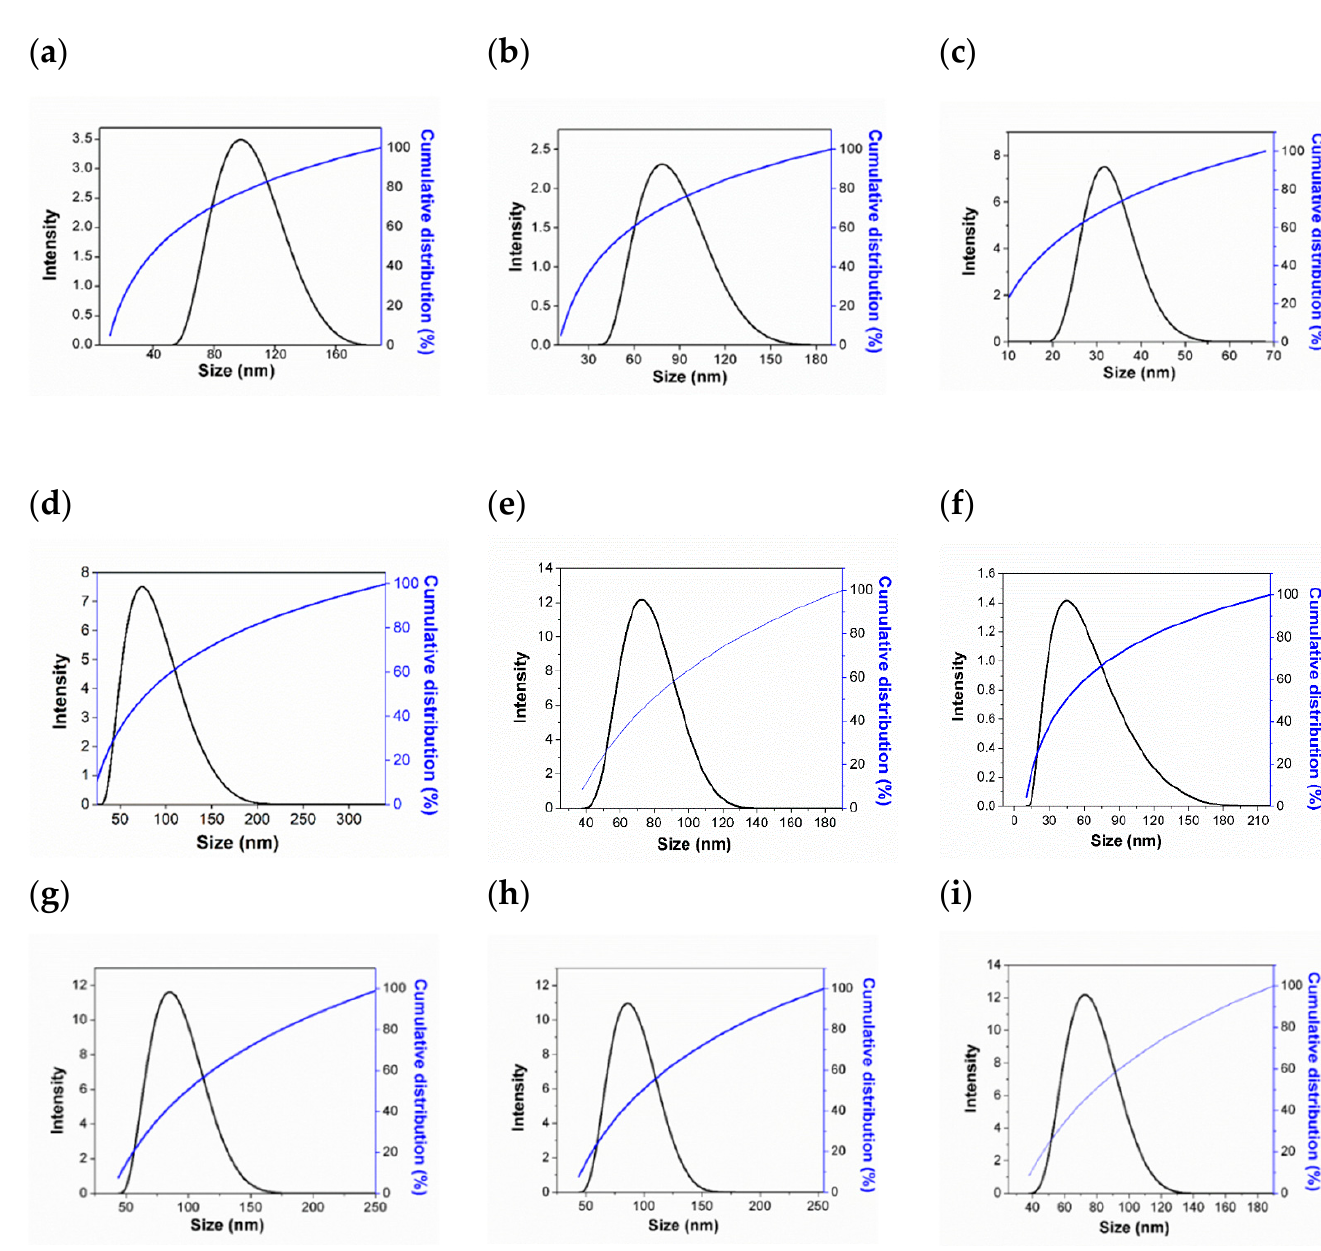
Figure 7. The dynamic light scattering particle size distribution of HMBS-1 ( a ), HMBS-2 ( b ), HMBS-4 ( c ), HMDS-1 ( d ), HMDS-2 ( e ), HMDS-4 ( f ), HMT-6 ( g ), HMT-8 ( h ) and HMT-10 ( i ).